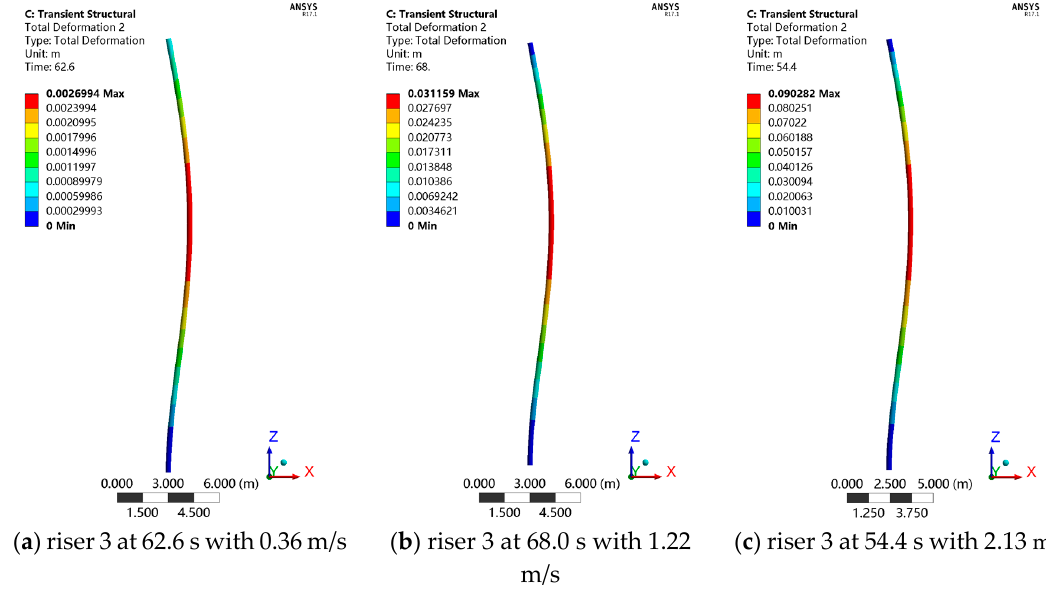
Figure 10. Maximum displacement of the riser 3: ( a ) at 62.6 s with 0.36 m/s, ( b ) at 68.0 s with 1.22 m/s and ( c ) at 54.4 s with 2.13 m/s.